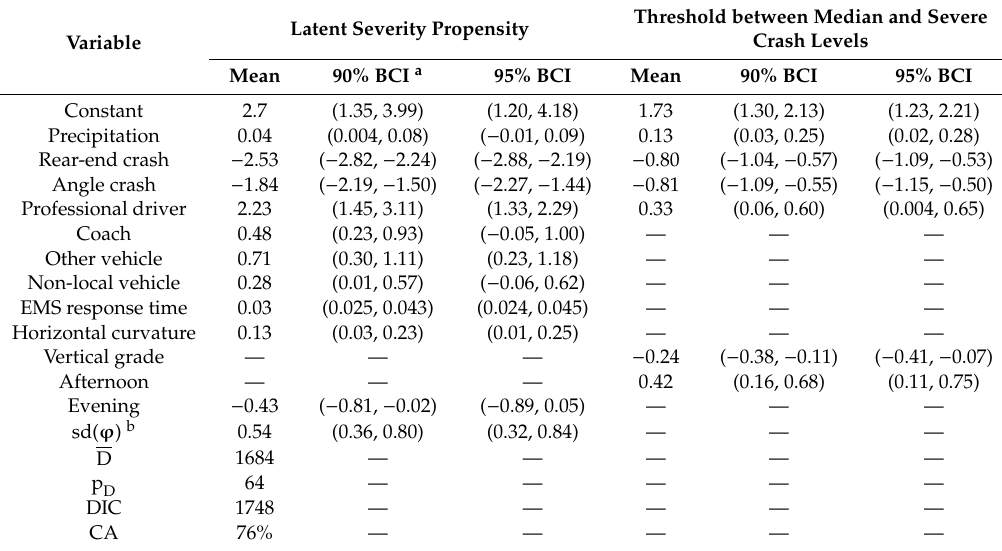
Table 3. Estimation and assessment results for the spatial generalized ordered logit model.